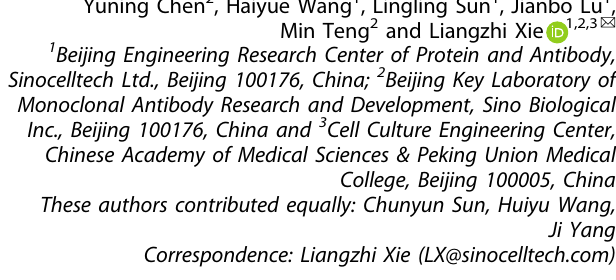
Fig. 1 Mutation N856K reduces BA.1 virulence. a S-mediated cell fusion by different SARS-CoV-2 variants. Vero-E6 were used as target cells and co-cultured with HEK293FT effector cells expressing spike-GFP of different SARS-CoV-2 variants or single GFP (negative control, NC) for 48 h. Images were presented as merge of GFP and DAPI signals. Syncytia were highlighted by dotted yellow lines. Scale-bar: 100 μ m. b Quantitative analysis of syncytia formation by SARS-CoV-2 variants. The experiments were performed in triplicate and the data were plotted as mean ± SD ( n = 3). c PsVs infection signals of SARS-CoV-2 variants. Vero-E6, Huh-7, and Calu-3 cells were infected with the PsVs of SARS- CoV-2 variants at equal viral particles counts at 1E8 for 24 h. The experiments were performed in triplicate and data were plotted as mean ± SD ( n = 9). Comparison was made between D614G, Delta, Omicron BA.2, BA.4/5, BA.2.12.1, BA.2.75, and Omicron BA.1, respectively. d Spike mediated cell – cell fusion of D614G and its N856K mutant, Delta and its N856K mutant, Omicron BA.1 and its K856N mutant. e PsVs Infection signals of D614G and its N856K mutant, Delta and its N856K mutant, Omicron BA.1 and its K856N mutant. f Electrostatic potential distribution on the solvent-accessible surfaces of the fusion peptides of D614G and N856K based on the PDB 7MY8 and a modeled structure, respectively. The electrostatic potential distribution was generated using the APBS Tools 2.1 in PyMOL. The surface potential representation has charge levels from − 5kT/e (red) to + 5kT/e (blue). The circles labeled with yellow lines indicated the binding region of Ca 2 + . g The interactions between residue 856 and its surrounding residues. The S2 subunits containing residue 856 in one protomer are in blue. The S1 subunits in another protomer are in green. Residues are shown as sticks. The hydrogen-bond and salt-bridge between residue 856 and other residues are shown as dashed lines in sky blue or dark blue, respectively. Superposition of the structures of the N856D/D568K mutant with that of the D614G S2 was superimposed and aligned. The predicted mutant structures were colored in yellow and the salt-bridge interaction between D856 and K568 was shown. h The schematic graphs of speculated structures in FP and S1/S2 interaction by structural analysis or modeling of D614 spike with residue 856 and/or 568 mutation designs and their speculated in fl uences/experimental results on fusion activity. The panel of “ FP Distortion ” shows the proposed structure of fusion peptide (FP) when the type of residue 856 is asparagine (N), lysine (K), or aspartic acid (D). The panel of “ S1-S2 Salt-bridge ” shows that whether a salt-bridge was formed between residue 856 in S2 and residue 568 in S1 or not. The “ Fusion Reduction ” indicates the speculations for weakening fusion activity ( + ) or not ( − ). The panel of “ Cell – cell fusion ” indicated the experimental results of different D614G spike mutation constructs, which was showed by “ cell fusion (%) ” . Images were shown as merging of the GFP and DAPI signals, scale-bar: 100 μ m. Quantitative analysis of cell fusion of different D614G spike mutants was shown below. The experiments were performed in triplicate and the data were plotted as mean ( n = 3); Comparison was performed (1) among D614G and its N856 single amino acid mutants designed for verifying the FP disturbance speculation, and (2) between single amino acid mutants and double amino acid mutants designed for S1/S2 interaction speculation. Data analysis was performed by unpaired two-tailed Student ’ s t -test with or without Welch ’ s correction for all statistical analyses. * p < 0.05, ** p < 0.01, *** p < 0.001, **** p < 0.0001, NS = p >